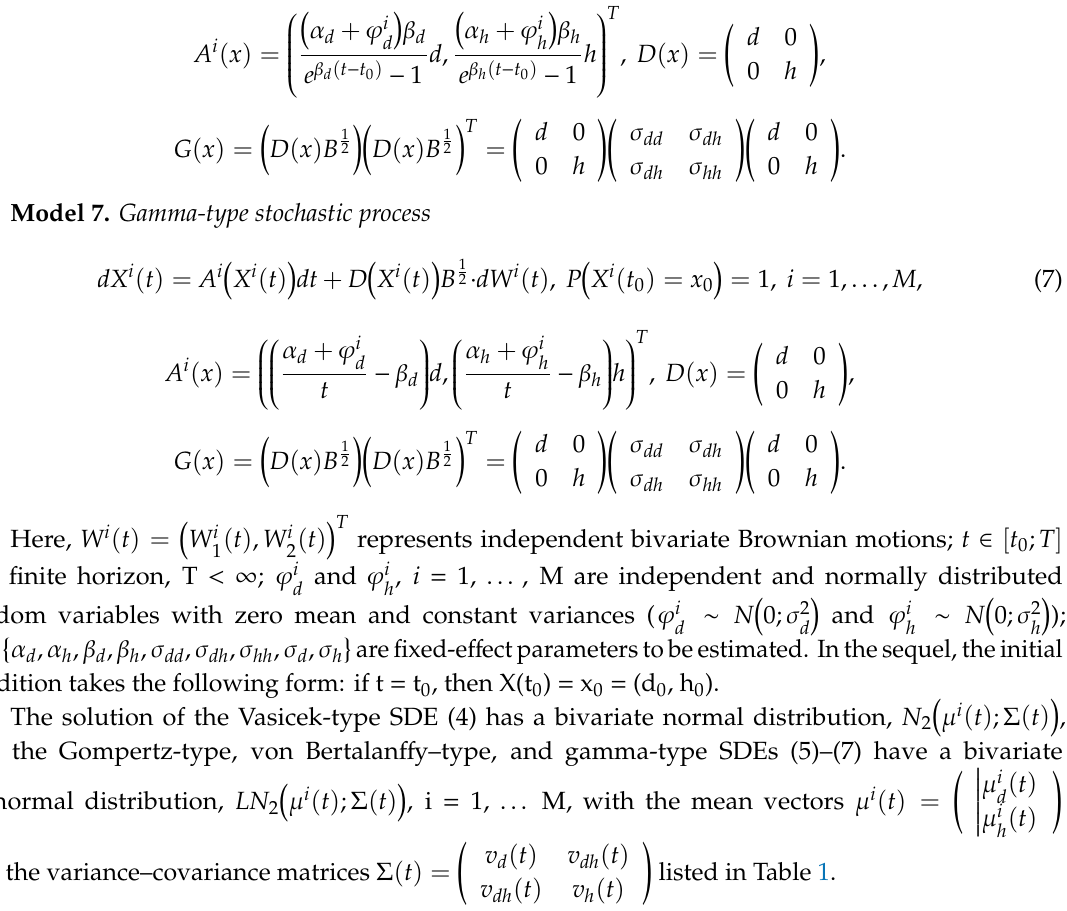
Table 1. Mean vectors and variance–covariance matrixes of bivariate probability density functions. SDE 1 Mean Vector µ ( t ) Variance–Covariance Matrix Σ ( t ) Vasicek